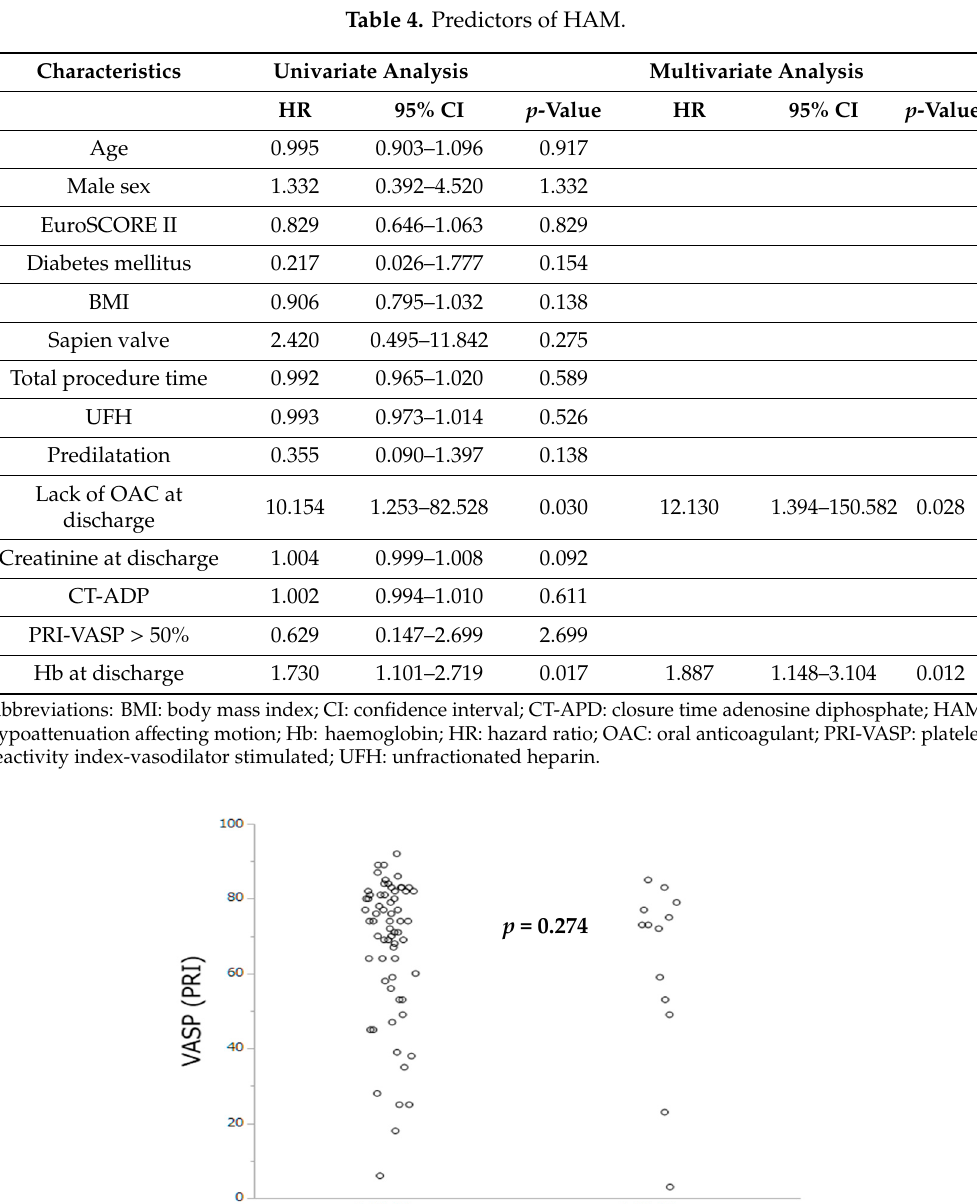
Figure 4. Platelet inhibition by PRI-VASP according to the occurrence of HAM